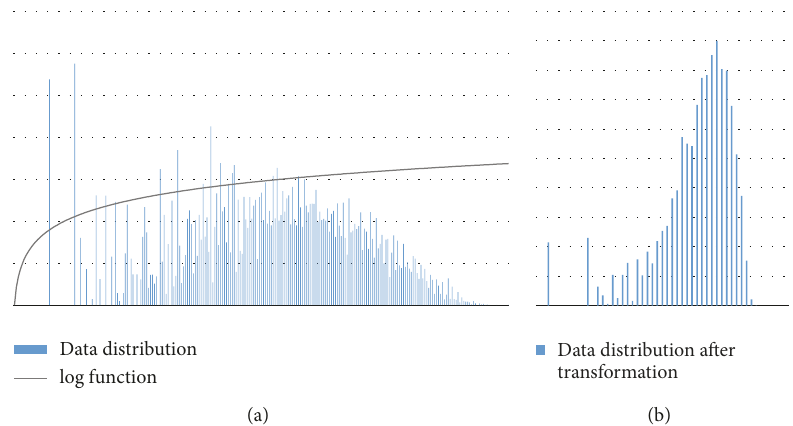
Figure 2: Data distribution example with nonlinear logarithm transformations (a). By applying this transformation, data distribution is expected to be more bell-shaped (“more Gaussian”) (b) that successfully modifies the distribution of pixels and supports the accuracy of the classifier proposed in